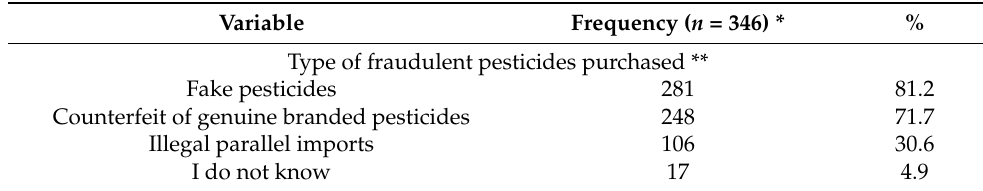
Table 6. Type of fraudulent pesticides